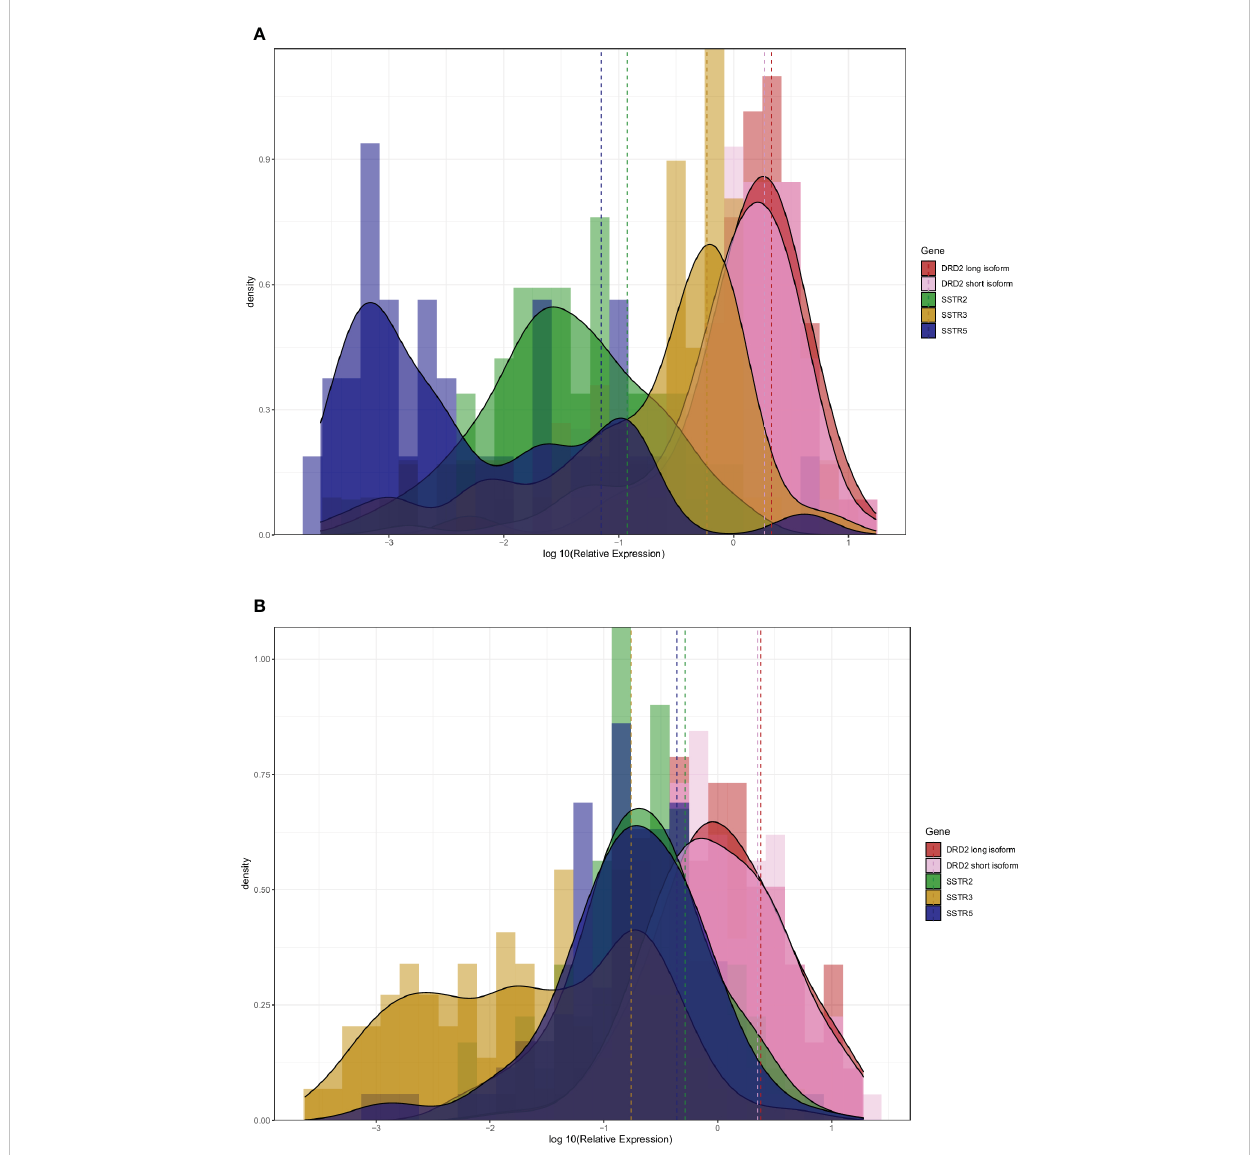
FIGURE 4 Histogram and density plot of the log 10 relative expression of DRD2 long and short isoform, SSTR2 , SSTR3 and SSTR5 in NF-PitNETs (A) and GH- secreting pituitary neuroendocrine tumors (B) . Dashed line showed the mean expression of each